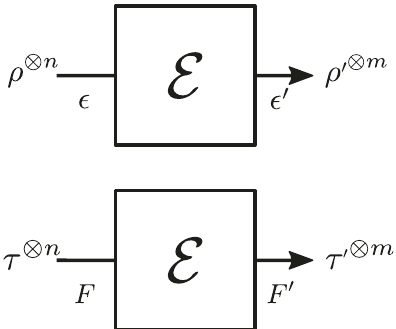
Fig. 2 Probing magic protocols with reference states. A magic protocol (top fi gure) converts n copies of some noisy magic state ρ with error parameter ϵ to m copies of some less noisy state ρ 0 with ϵ 0 < ϵ . The physics of the protocol can be analysed by considering how it would transform some distinguished reference stabilizer state τ ⊗ n (bottom fi gure). For the case where this reference state is a thermal state at some temperature T our magic distillation bounds are functions of T , the error parameters ϵ ; ϵ 0 , and free energies F ; F 0 . In addition, a quantity ϕ (Eq. 41) relates the computational and energy bases, and corresponds to the degree to which the Wigner negativity of ρ can be given a sharp energy via the system